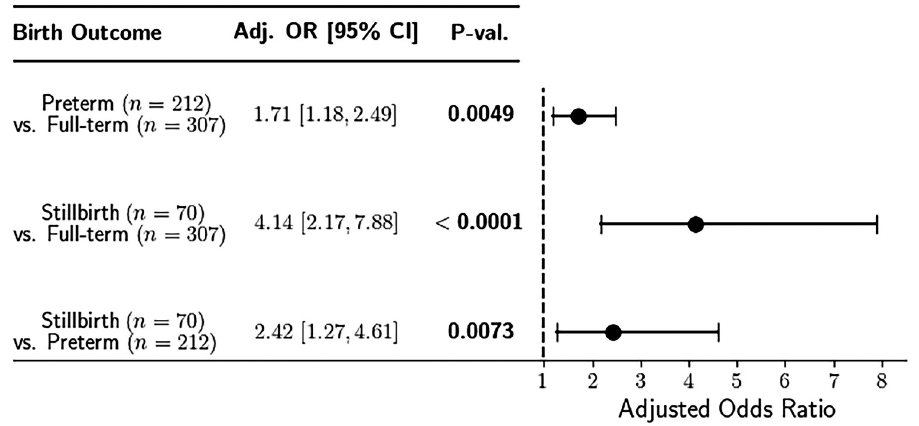
Fig 2. Odds ratios of having TIs in full versus preterm and stillbirth placentas. Forest plot of adjusted odds ratios for identification of placental trophoblast inclusions across three birth outcomes.